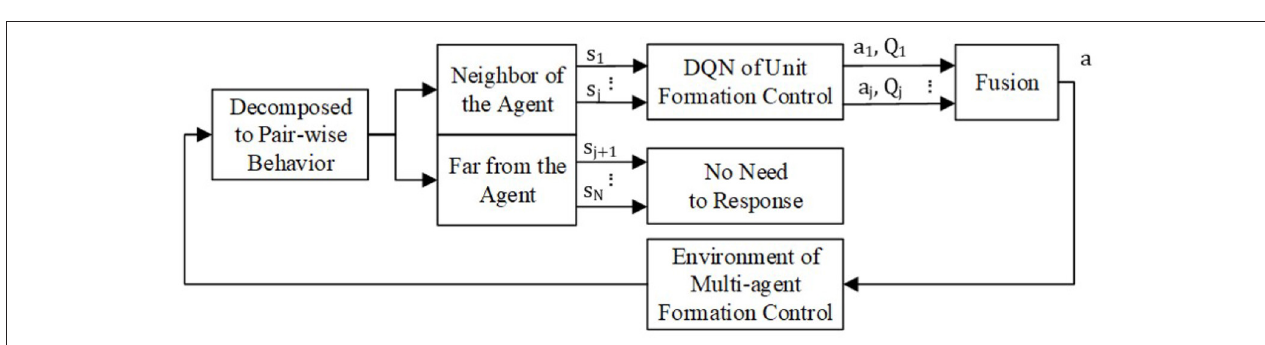
FIGURE 5 | Policy fusion for multi-agent formation